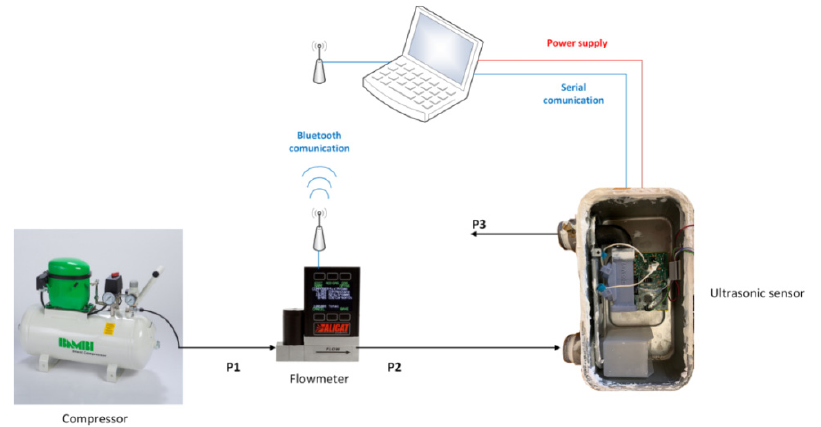
Figure 2. Experimental